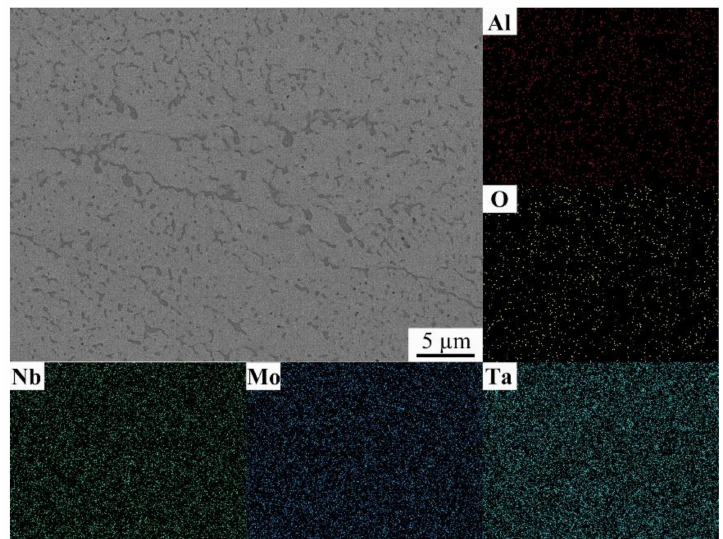
Figure 5. An EDS image of the NbMoTa–Al 2 O 3 composite structure. The theoretical melting point of NbMoTa is 2750 ◦ C, the melting point of Al 2 O 3 is 2054 ◦ C, and the boiling point is 2980 ◦ C. Due to the prolonged reheating and diffusion time during LDED, the Al 2 O 3 distribution in the continuously formed composite structure was uniform. The solidification rate of the melt pool remained the same, and the grain structure and morphology of the melt pool remained the same. When depositing NbMoTa, the temperature of the composite structure definitely exceeded the melting point of Al 2 O 3 , causing remelting of Al 2 O 3 , as shown in Figure 6. The remelting by the laser makes the existing Al 2 O 3 become liquid, at which time the Nb, Mo, Ta, and Al 2 O 3 materials are present inside the melt pool together, and this fluidity leads to a more adequate diffusion and makes it possible to form new substances from Nb, Mo, Ta, and Al 2 O 3 .